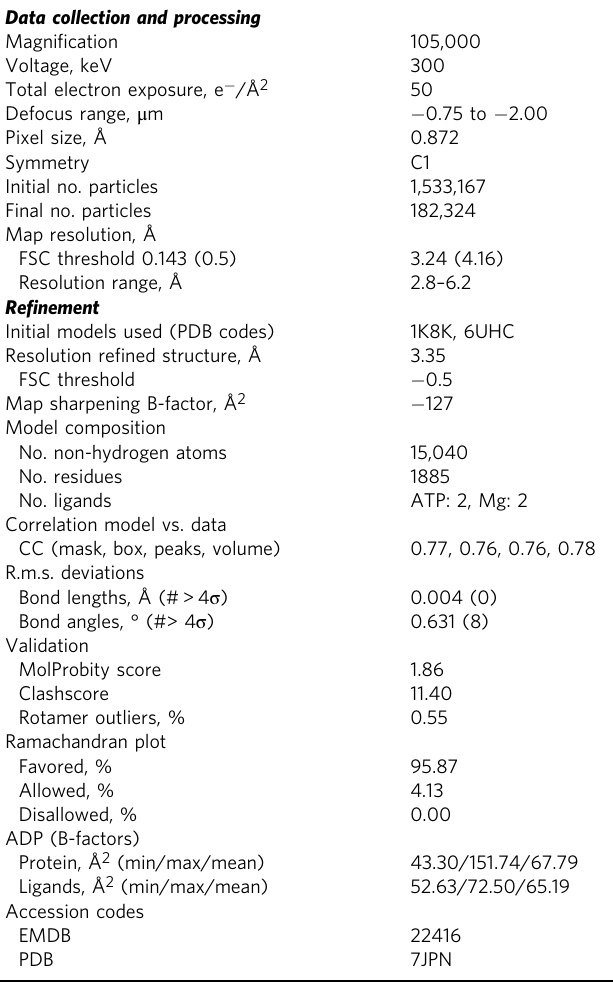
Table 1 Cryo-EM data collection, re fi nement, and validation statistics (Arpin_CA-Arp2/3